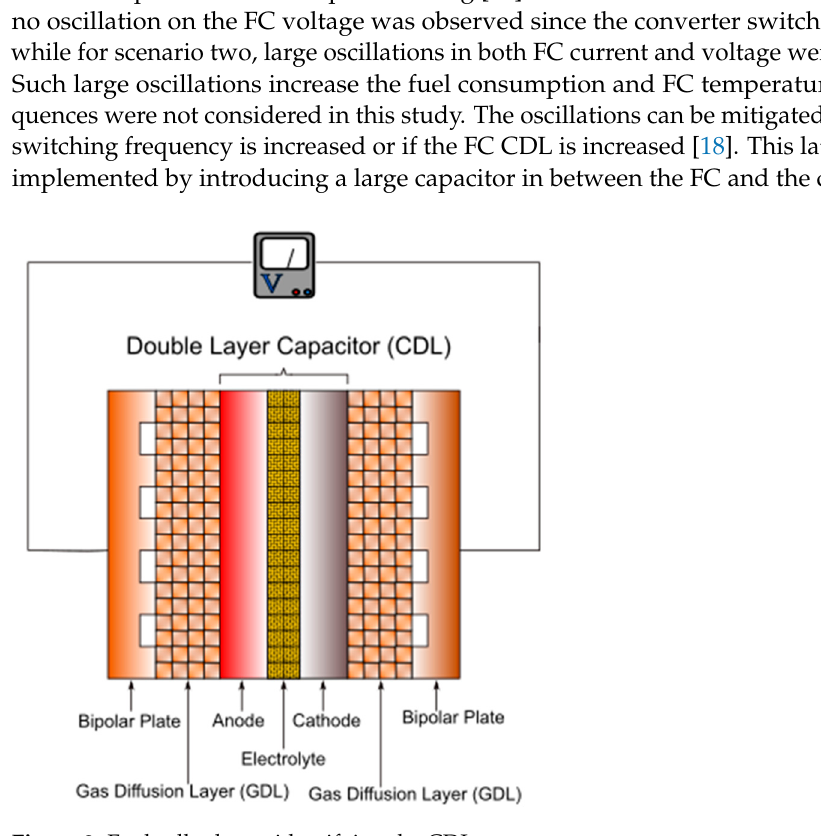
Figure 2. Fuel cell scheme identifying the CDL.